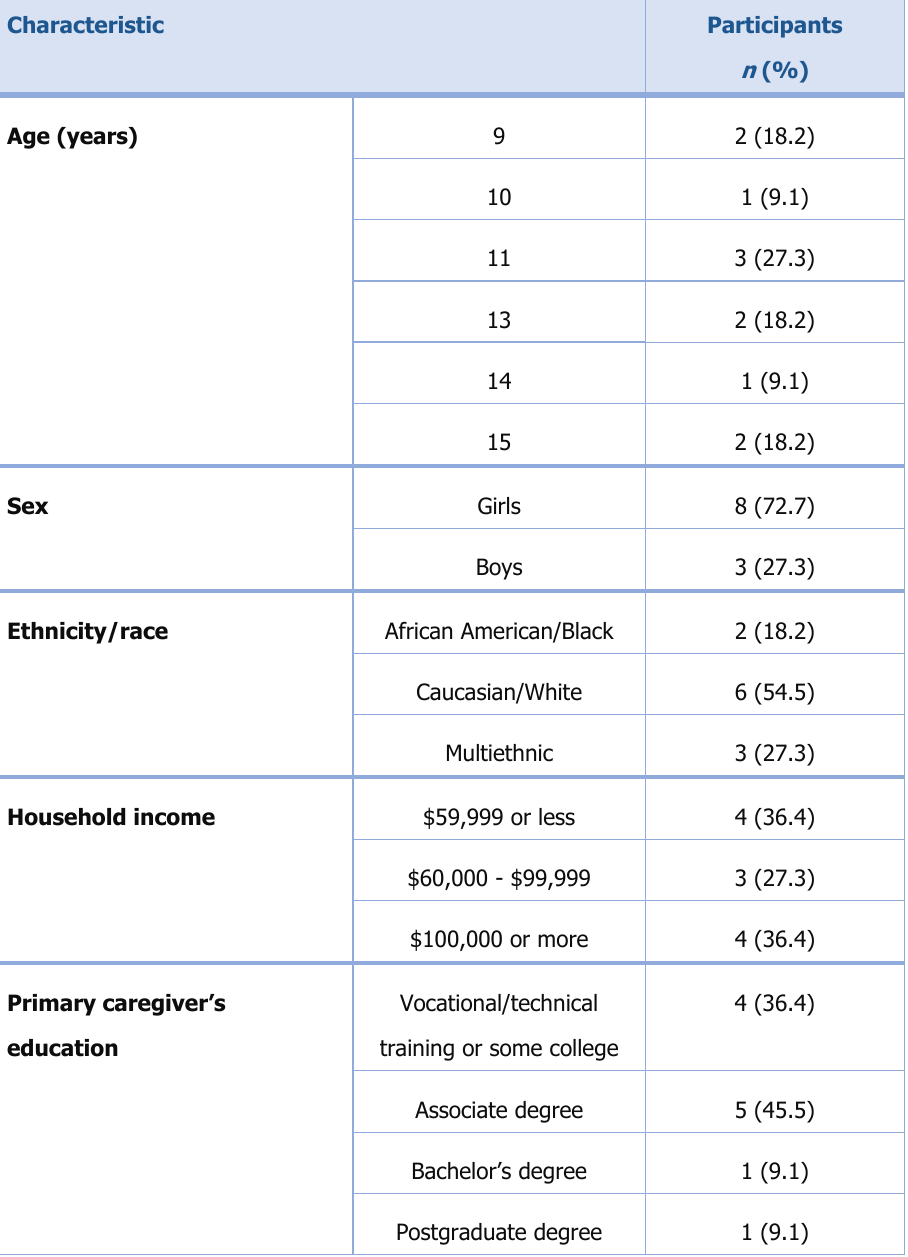
Table 3. Characteristics of 1 st -Year Participants (n = 11)